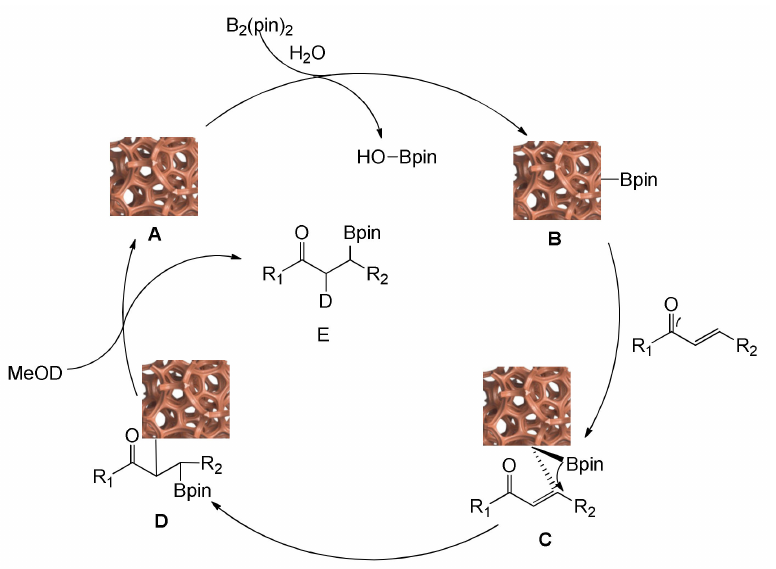
Figure 7. Possible reaction